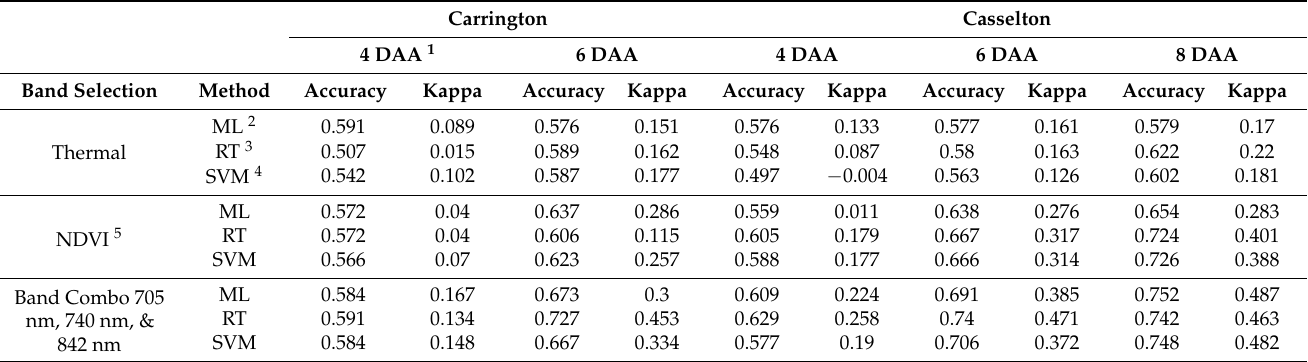
Table 5. Kochia Classification Performance